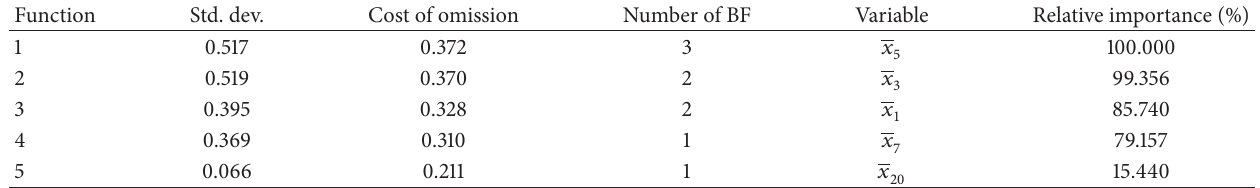
Table 4: Basis functions and important explanatory variables for the MARS model with ( 𝜌 , 𝛿 𝑖 ) = (0.1, 1.0). Function